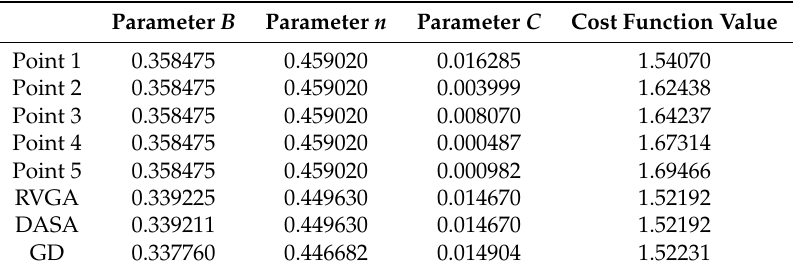
Table 7. Full-factorial experiment response